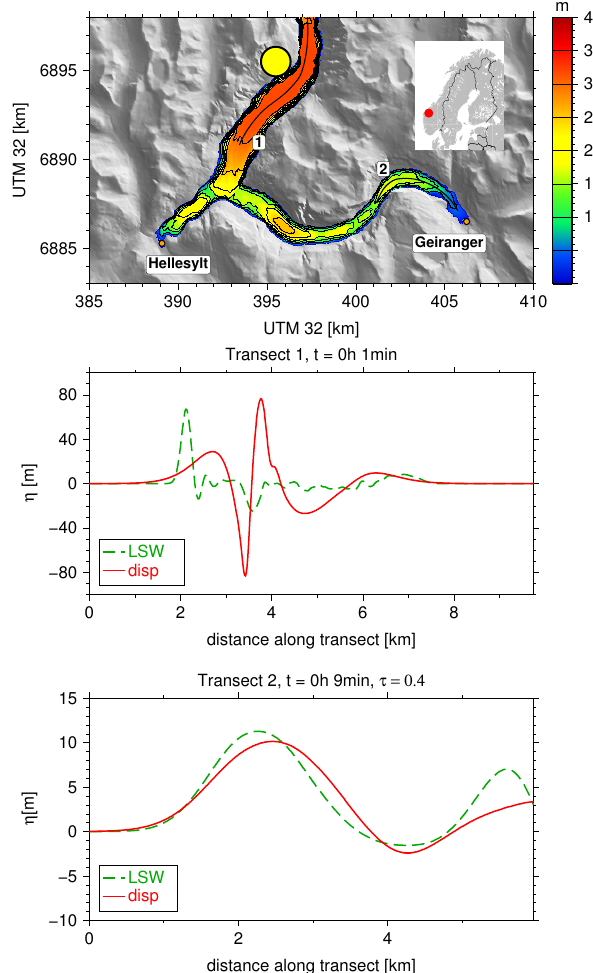
Fig. 16. Upper panel: Bathymetry of the inner part of the fjord sys- tem. ˚Akerneset is marked with a large yellow bullet. The numerical solutions are evaluated along the two transects 1 and 2. The depth is given in meters. Mid panel: LSW and linear dispersive solutions at the generation area (transect 1, surface elevation). The leftmost waves are propagating to the left (south) and the rightmost waves are propagating to the right (north). The center line of the slide mo- tion is found at about 3 . 5km . Lower panel: Solutions along transect 2 outside Geiranger (surface elevation).